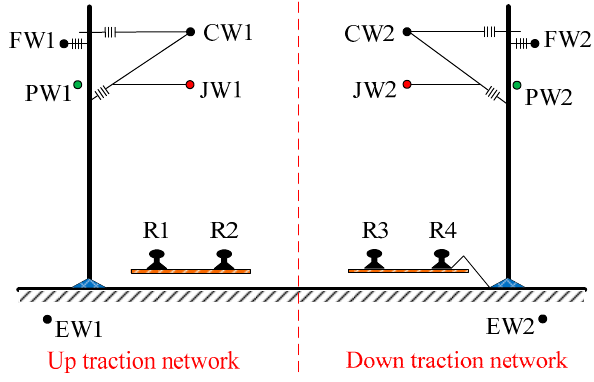
Figure 2. Typical cross section of auto-transformer (AT) double-track system. Table 1. Loop circuit number of conductors in standard 2 × 25 kV auto-transformer (AT) railway system line.